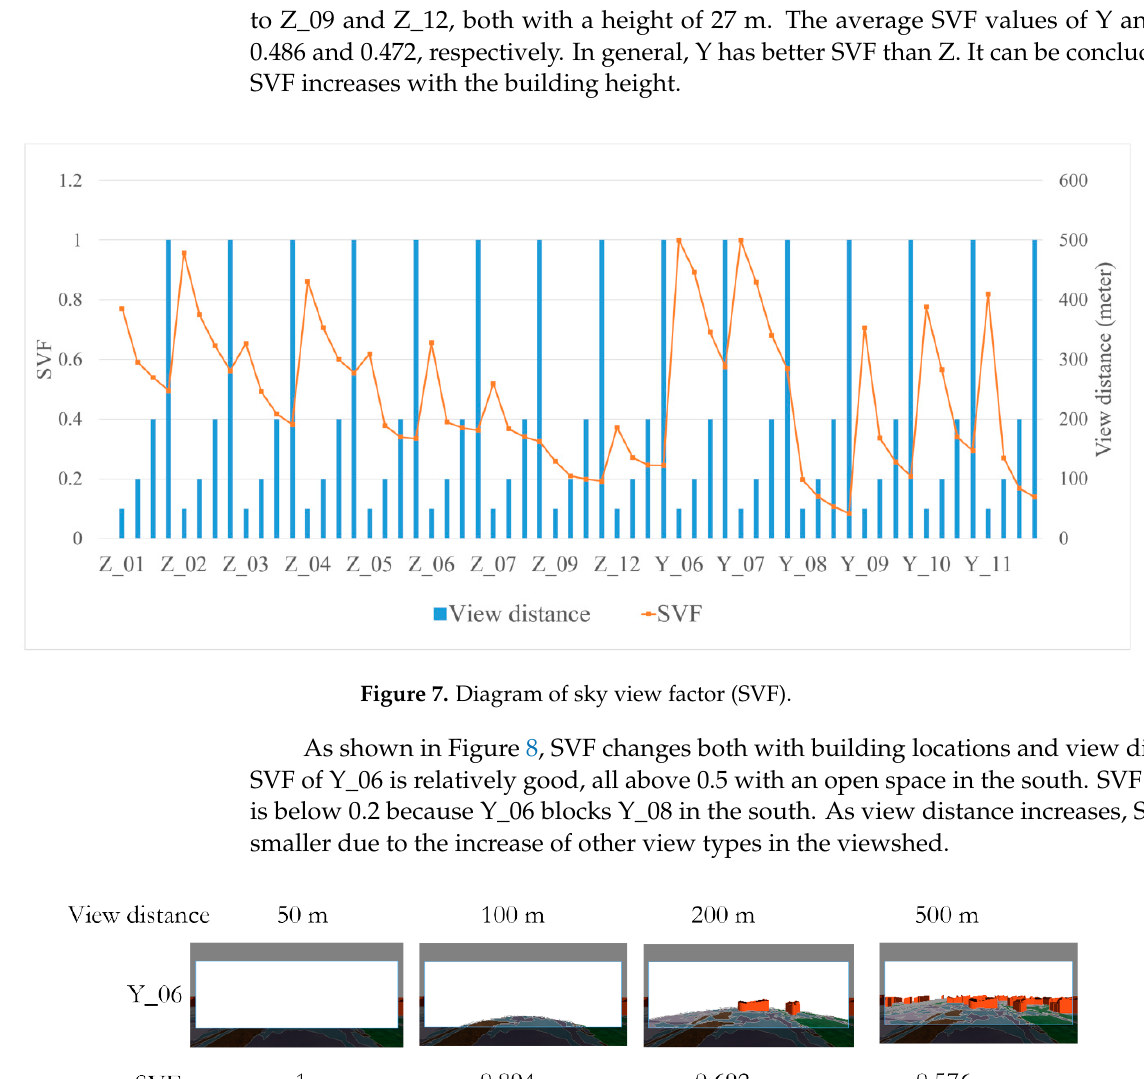
18 of 27 Figure 6. Diagram of view quality.